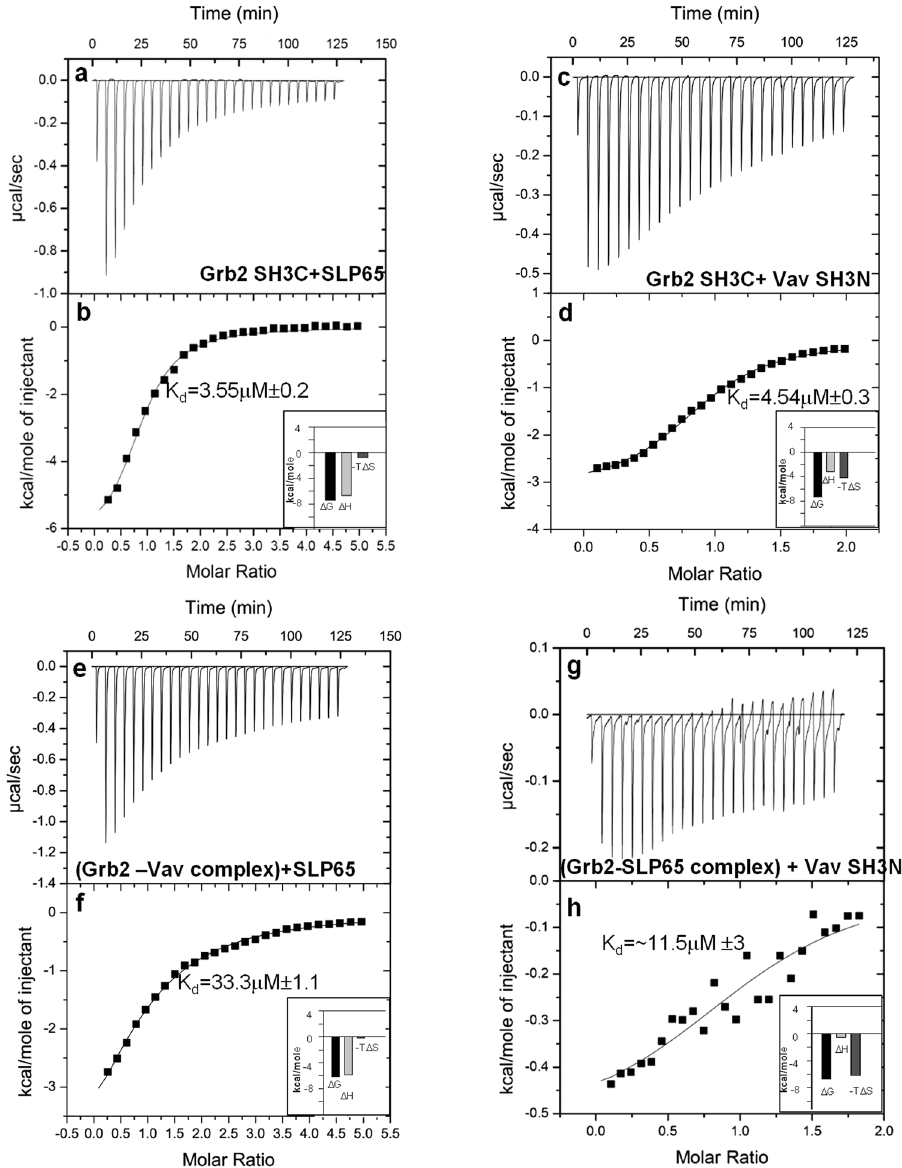
Figure 6. Isothermal Titration Calorimetry measurements. ITC titration profiles for the free Grb2 SH3C domain upon binding ( a and b ) the SLP-65 peptide, ( c and d ) Vav SH3N domain. The titration of ( e and f ) the Grb2-Vav complex with SLP65 peptide (resulting in Complex 1), and ( g and h ) Grb2-SLP65 with Vav SH3N (giving rise to Complex 2). The upper panels in the figure represent the ITC thermograms displaying the time dependent deflection of heat after each injection, and the lower ones display peak integrals as a function of molar ratio.